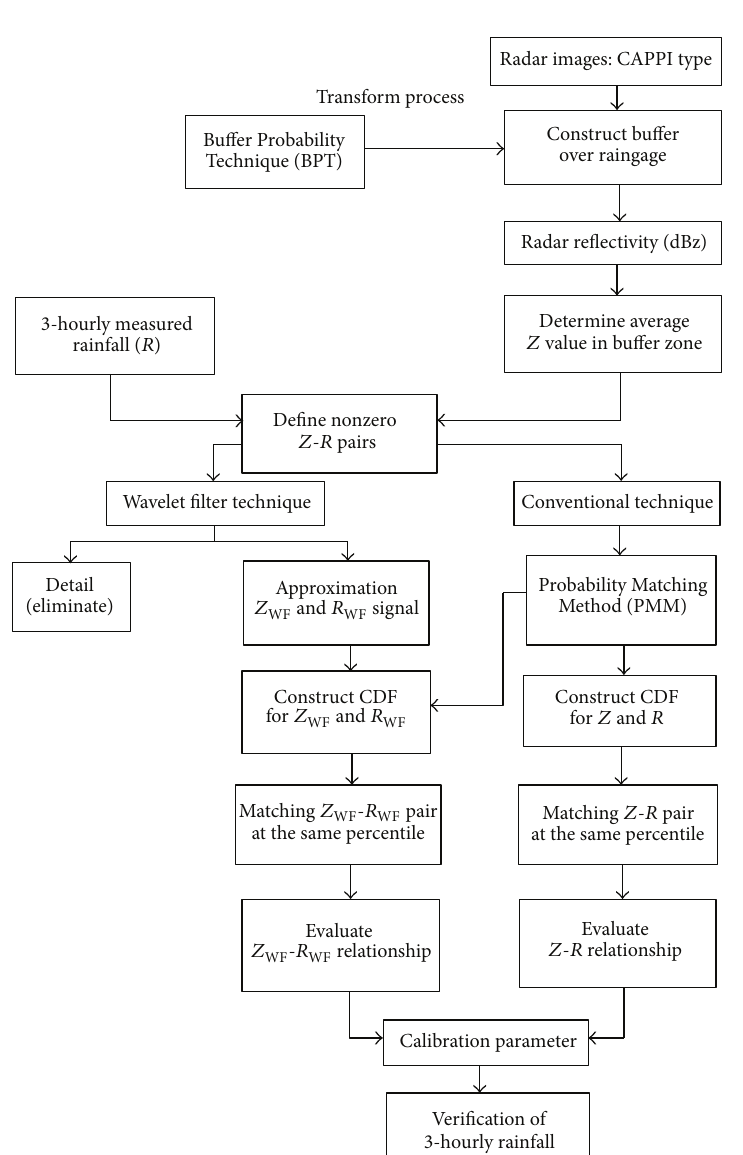
Figure 4: Studies process for rainfall estimating by 𝑍 - 𝑅 relationship comparison between the conventional and wavelet filter